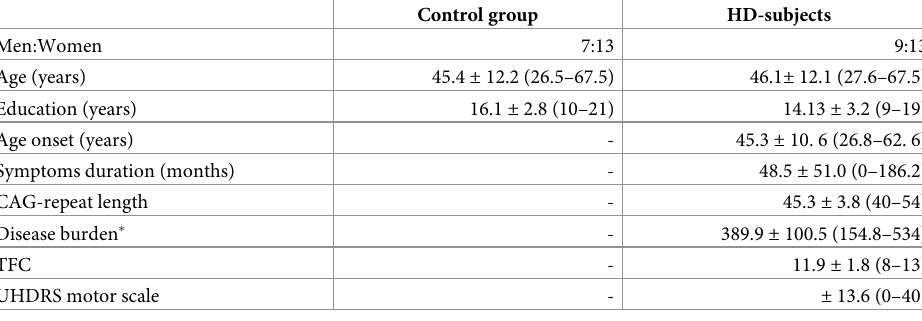
Table 1. Clinic and demographic groups